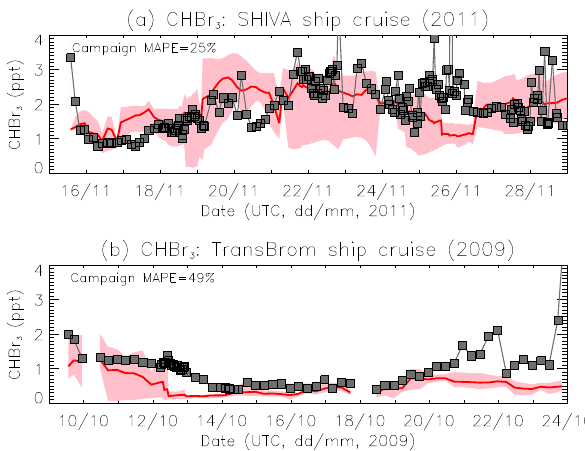
Figure 9. As Fig. 8 but for CH 2 Br 2